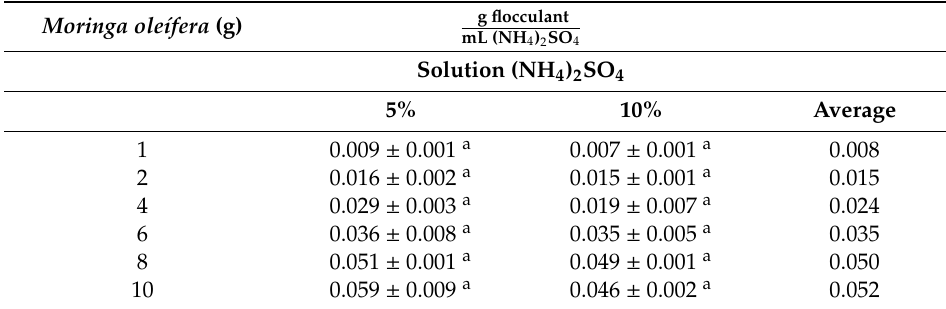
Table 2. Flocculant content extracted from Moringa oleifera (g) per volume of extracted solution (mL). Moringa ole í fera (g)